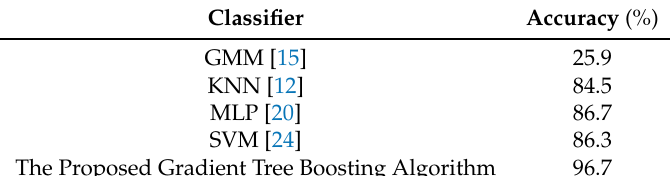
Table 3. Classification Performance of Algorithms after PCA Preprcessing.